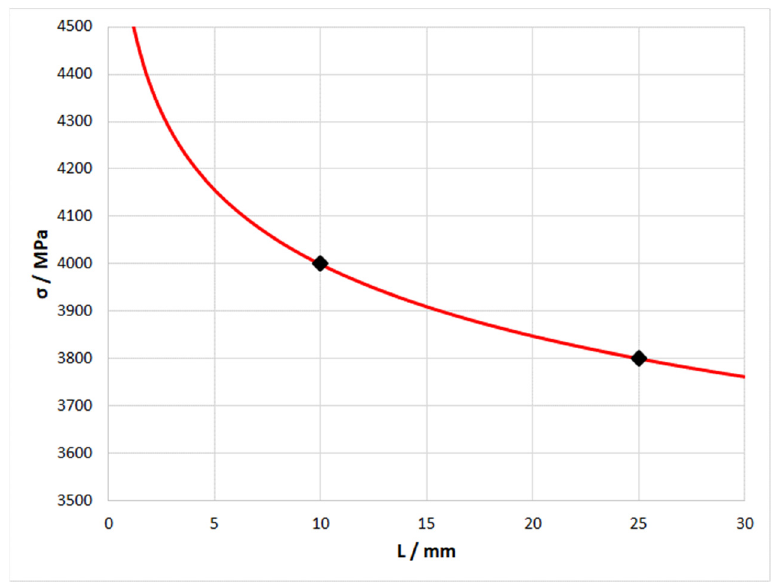
Figure 11. Plot of the fiber strength versus the length according to the Weibull distribution (red curve) and the manufacturer’s data on the fiber strength (black dots).